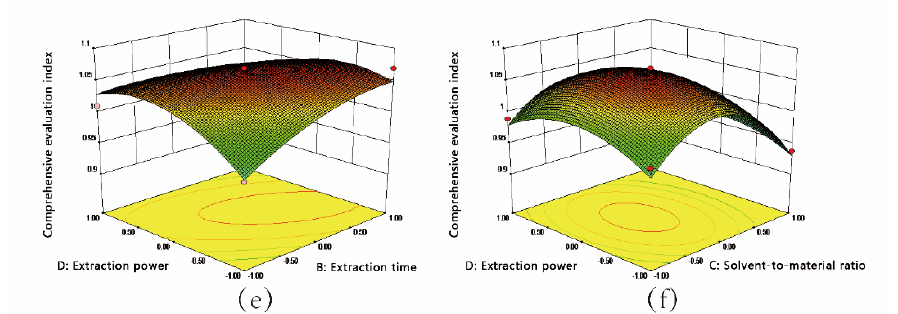
Figure 3. Response surfaces of the comprehensive evaluation value of HSYA and AHSYB yield: ( a ) Temperature (A) and Extraction time (B); ( b ) Temperature (A) and Solvent-to-material ratio (C); ( c ) Temperature (A) and Extraction power (D); ( d ) Extraction time (B) and Solvent-to-material ratio (C); ( e ) Extraction time (B) and Extraction power (D); and ( f ) Solvent-to-material ratio (C) and Extraction power (D).